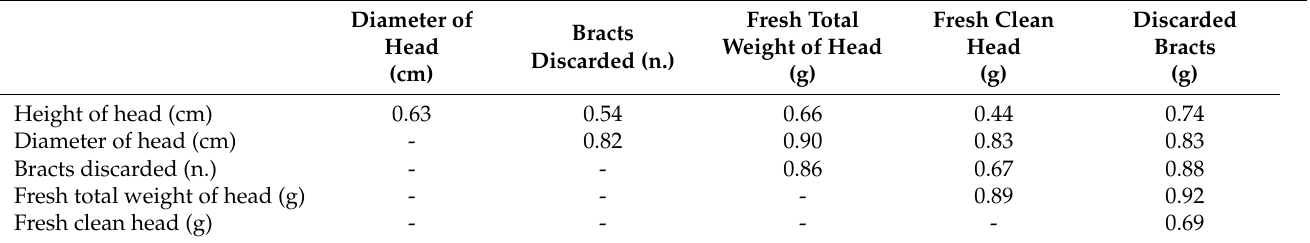
Table 2. Pearson’s correlation between the parameters measured on heads at harvest and on process- ing residues 1 .